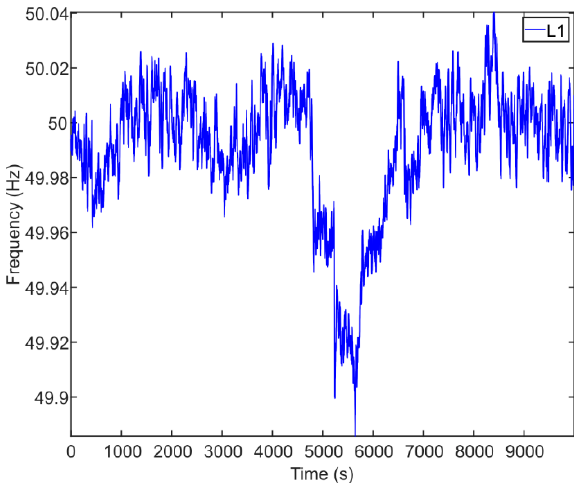
Figure 4. Temporary changes in fundamental frequency.